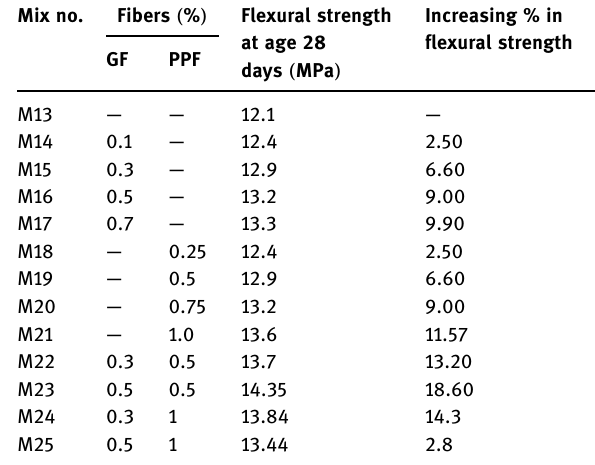
Table 14: Splitting tensile strength results of HSC mixes Mix no.